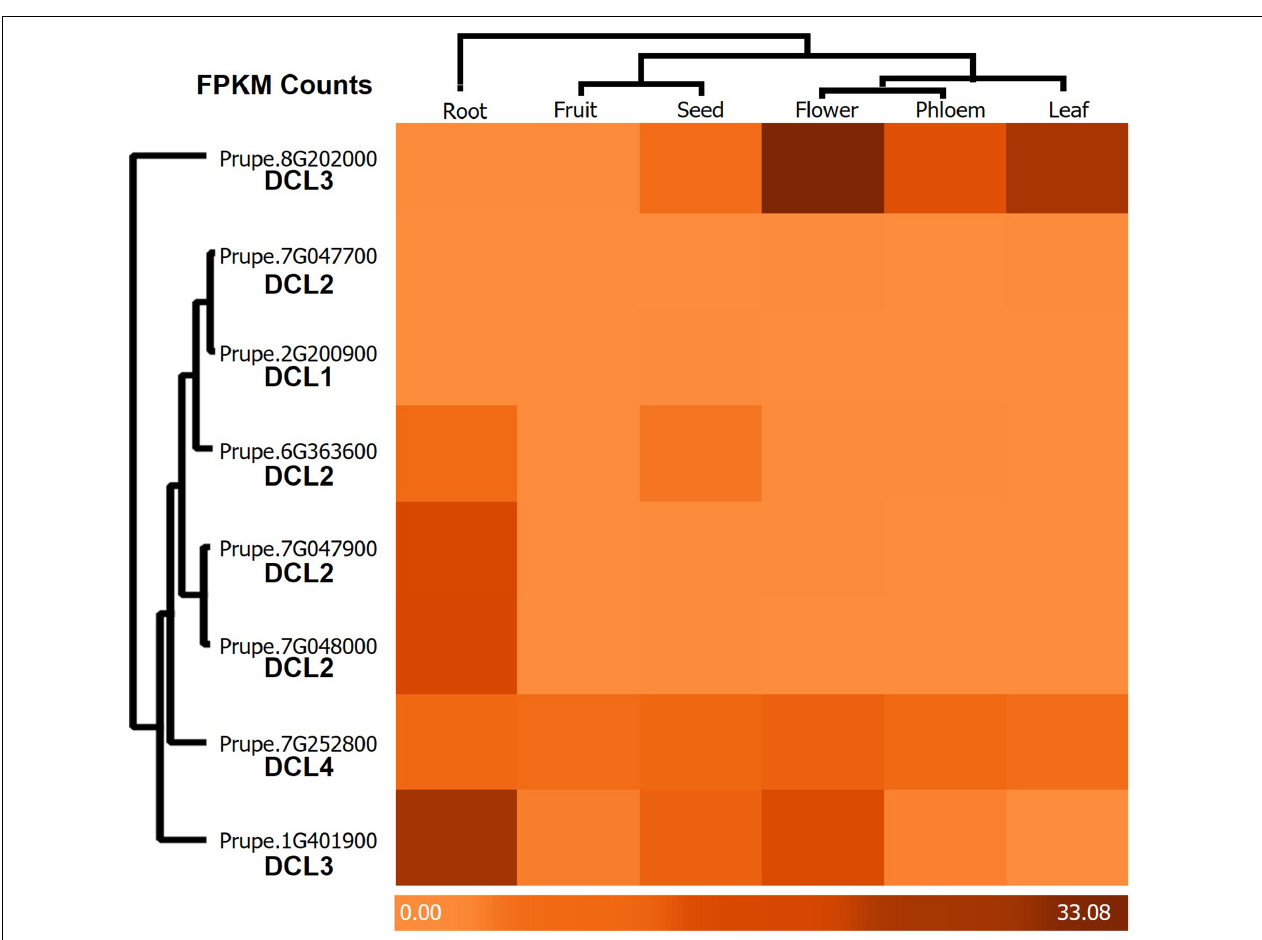
FIGURE 4 | Heatmap of tissue expression pattern of PrupeDCLs blast data in Root, Fruit, Seed, Flower, Phloem, and Leaf by FPKM counts. The color bar showed the expression degree. The phyletic clades were designed within FPKM values counts to identify the most relative items for